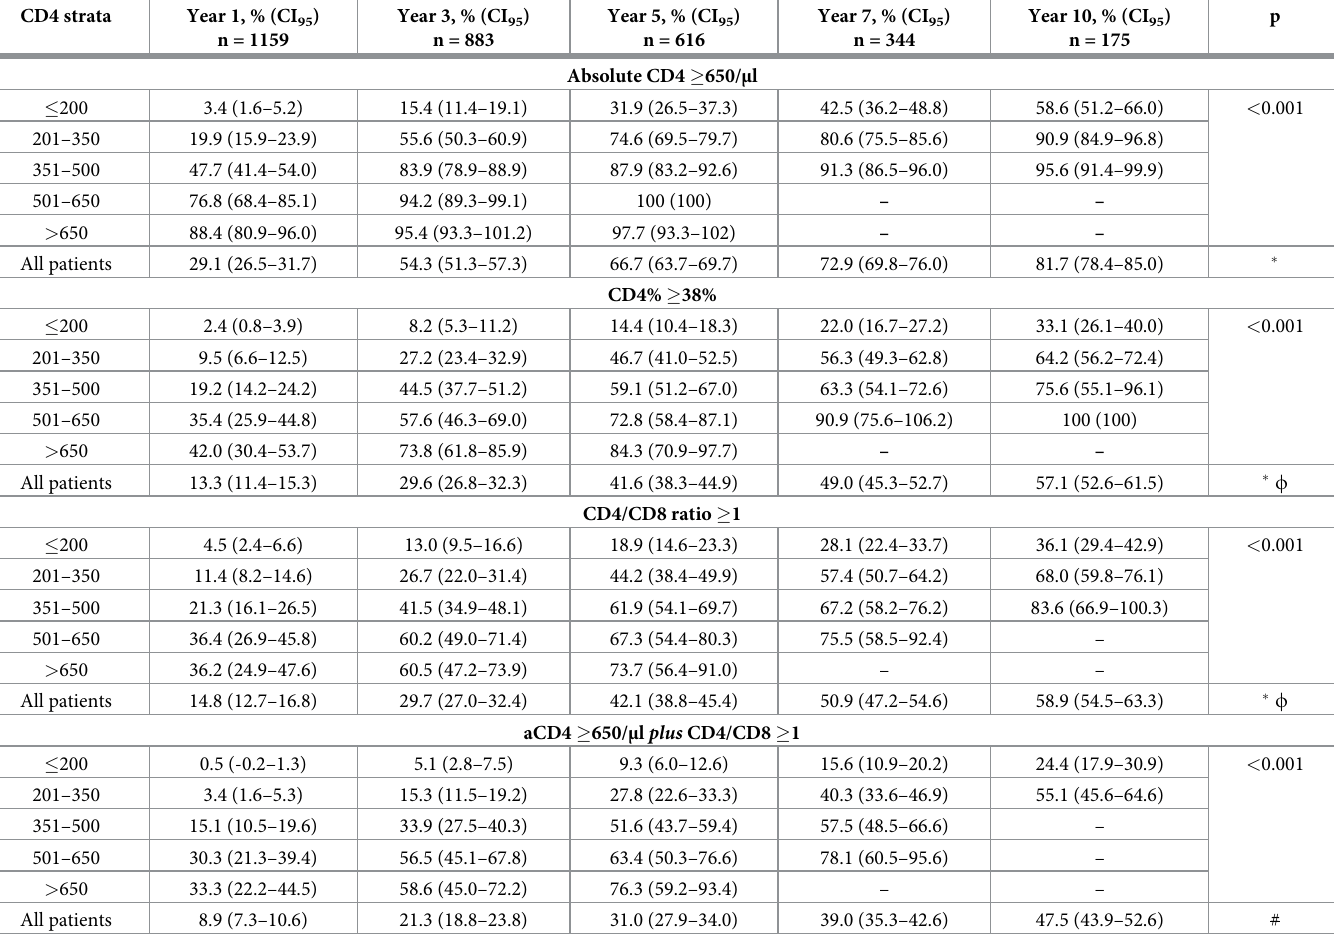
Table 3. Cumulative probabilities of achieving absolute CD4 � 650/ μ l, CD4% � 38%, a CD4/CD8 ratio � 1, and extensive immune recovery (eIR), defined as achiev- ing an aCD4 � 650/ μ l plus a CD4/CD8 ratio � 1, by years of follow-up expressed as percent (CI 95